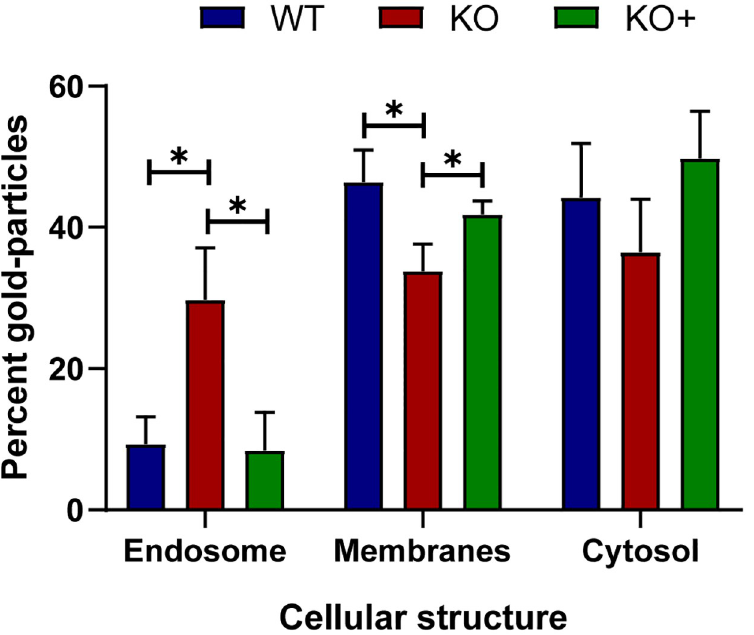
Fig 6. Quantification of reovirus core distribution following adsorption of WT, KO, and KO+ cells. The subcellular distribution of gold-labeled reovirus cores following adsorption of cycloheximide-treated WT, KO, and KO+ HBMECs (Fig 5) was enumerated. The results are presented as the mean of three independent counting sessions for each cell line. Error bars indicate standard deviation. � , P < 0.05, as determined by two-tailed unpaired t-test.